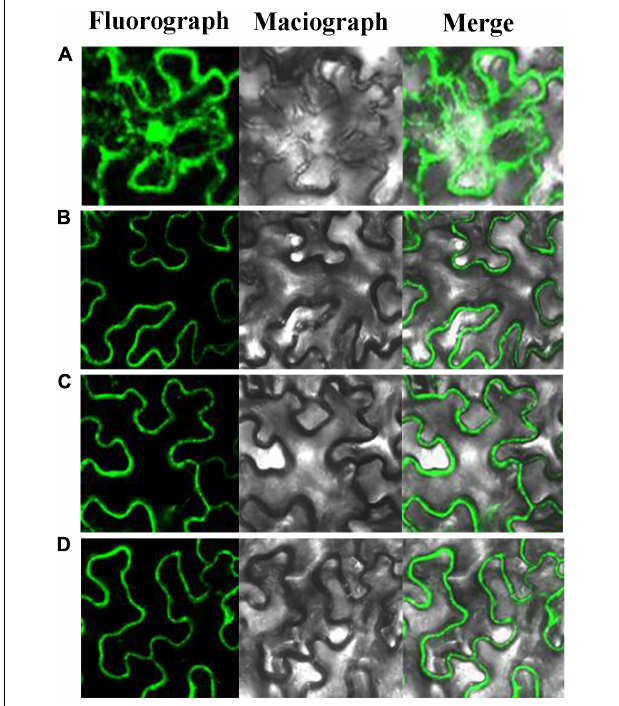
FIGURE 4 | Subcellular localization of PbBGLU1-GFP, PbBGLU15-GFP, and PbBGLU16-GFP fusion protein. (A) GFP control; (B) Subcellular localization of PbBGLU1-GFP fusion protein; (C) Subcellular localization of PbBGLU15-GFP fusion protein; (D) Subcellular localization of PbBGLU16-GFP fusion